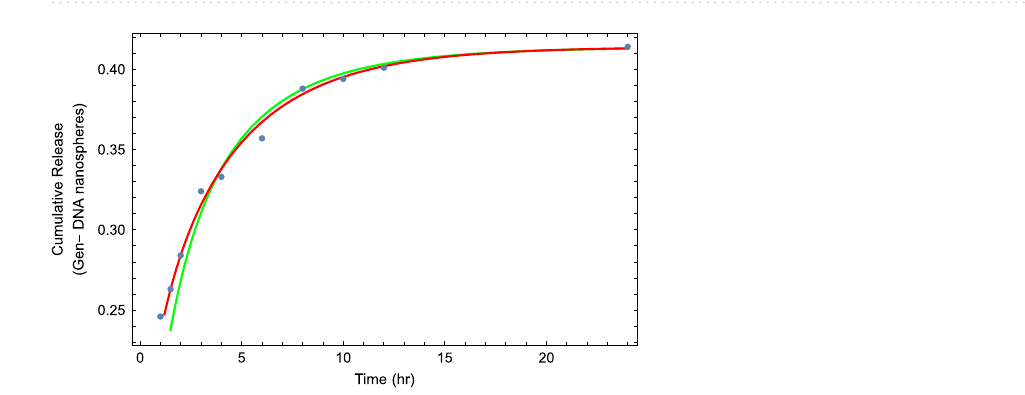
Figure 12. The fitting of experimental drug release data with the fractal kinetic model (green curve) and tempered fractional kinetic model (red